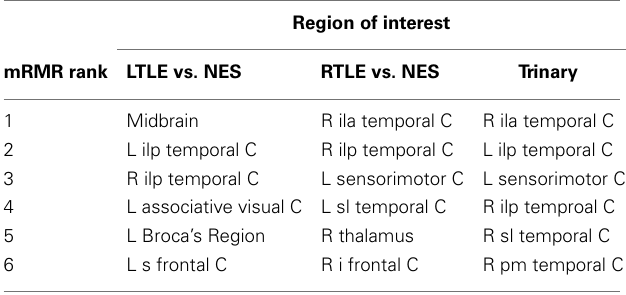
Table 2 | Ranked list of contributing metabolic